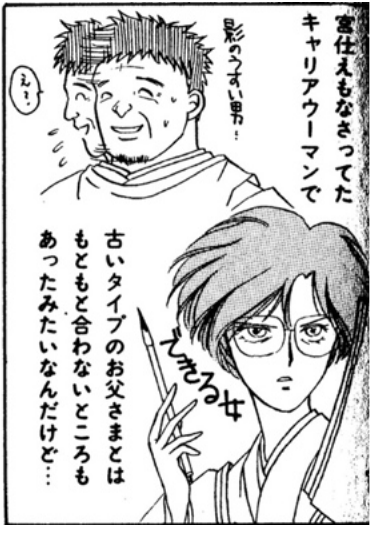
Figure 5. Sara-chan’s stepmother is a “career woman” (Hazaki 1991, 73). Courtesy of Courtesy of